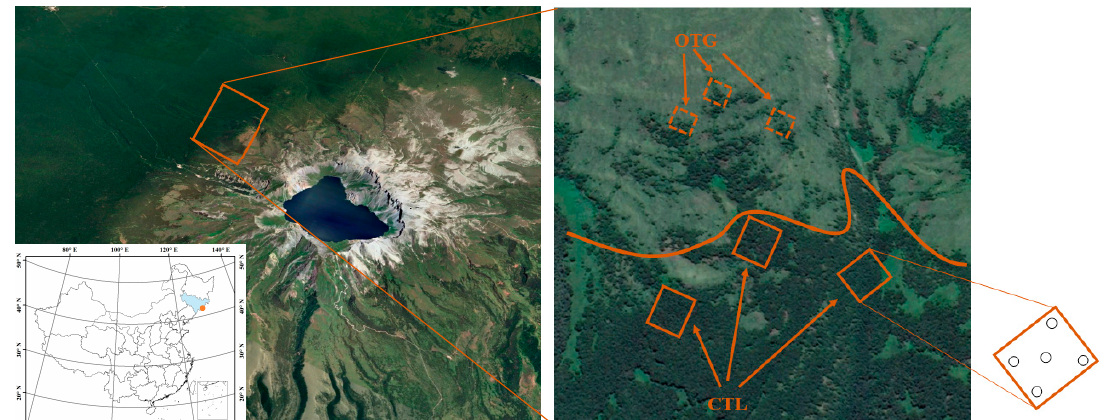
Figure 1. Study sites and plots located on the north-facing slope of Changbai Mountain, Northeast China. Rectangles with solid lines represent investigated study plots close to the continuous treeline (CTL, ~1950 m above sea level (a.s.l.)), rectangles with dotted lines represent outposts of tree groups (OTG, ~2050 m a.s.l.) (Adapted from Google Earth image), 5 birches in each plot were selected for